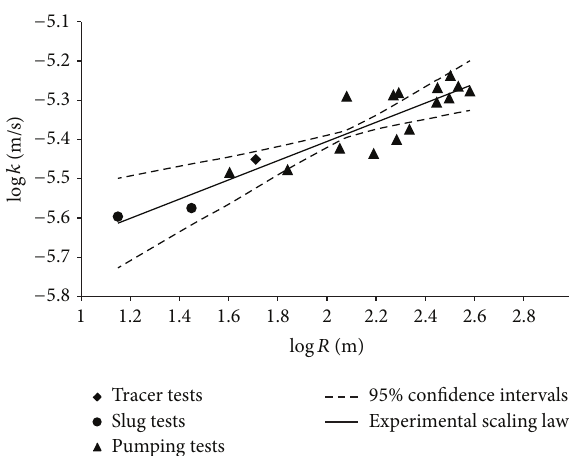
Figure 9: Trend of hydraulic conductivity versus scale for all field data